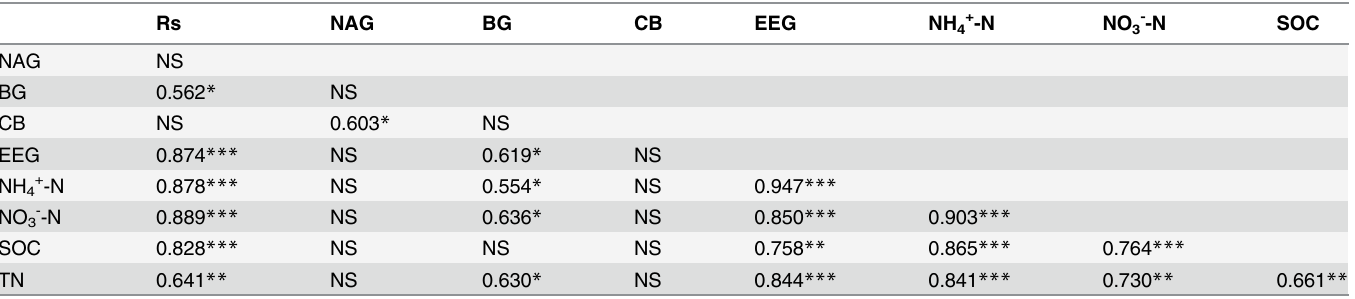
Table 5. Correlation matrix of soil respiration and soil biochemical parameters by using winter wheat growing season means during 2013 –